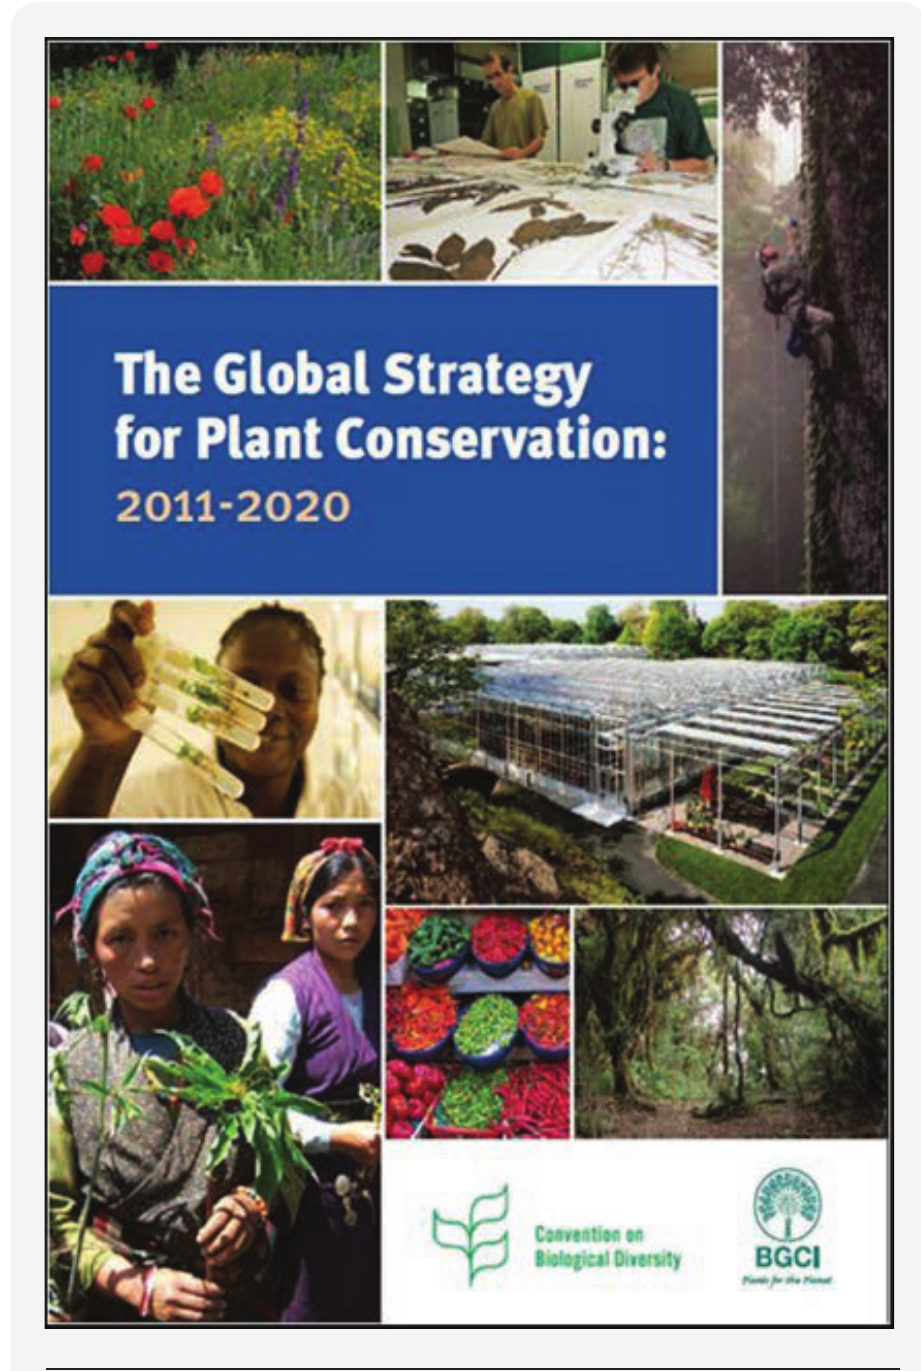
Figure 1. The Global Strategy for Plant Conservation, 2011–2020, provides an agreed international framework for plant conservation